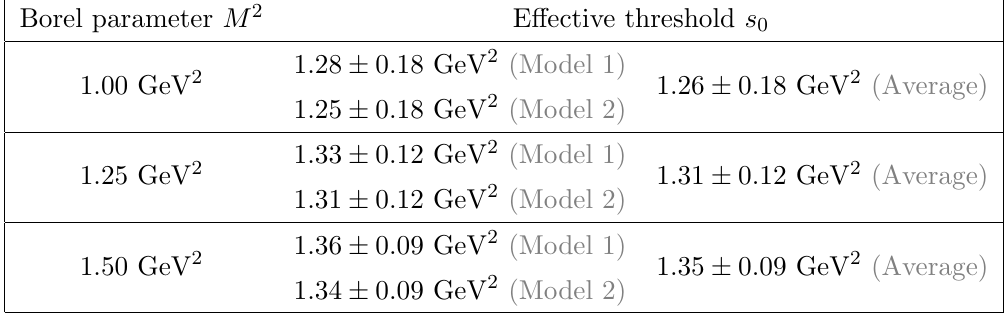
Table 3 . Values for the e(cid:11)ective threshold s 0 extracted from the SVZ sum